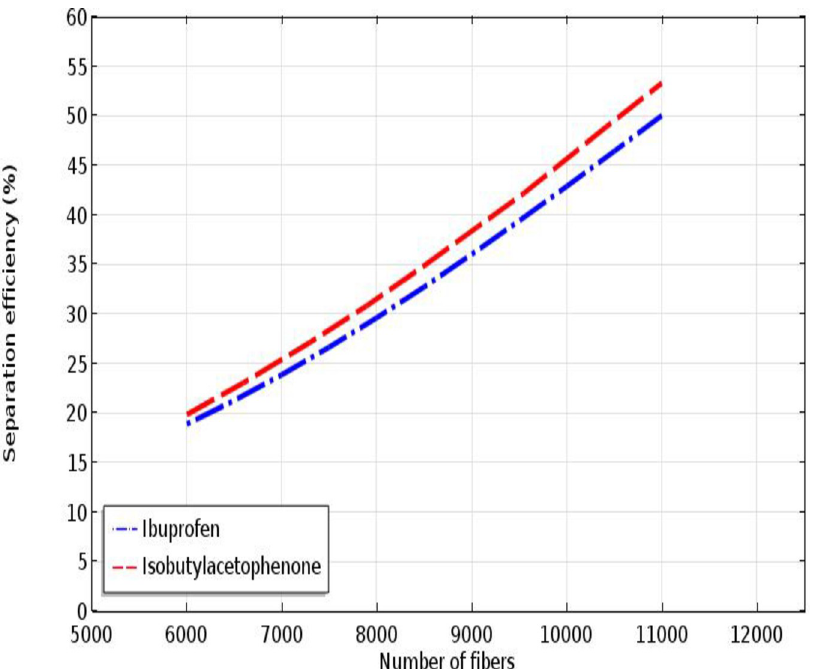
Fig 11. Effect of the number of fibrous membrane on the IP and 4-IBAP solutes molecular separation.